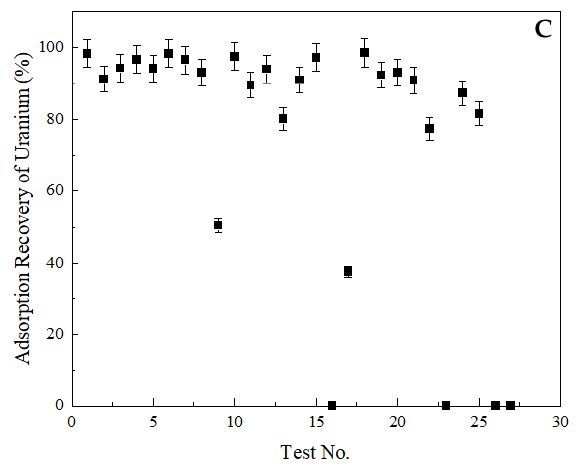
Figure 4. Adsorption recoveries into the solid phase. ( A ) total rare earths, ( B ) thorium, ( C ) uranium. Error bars represent one standard deviation of multiple replicate tests.